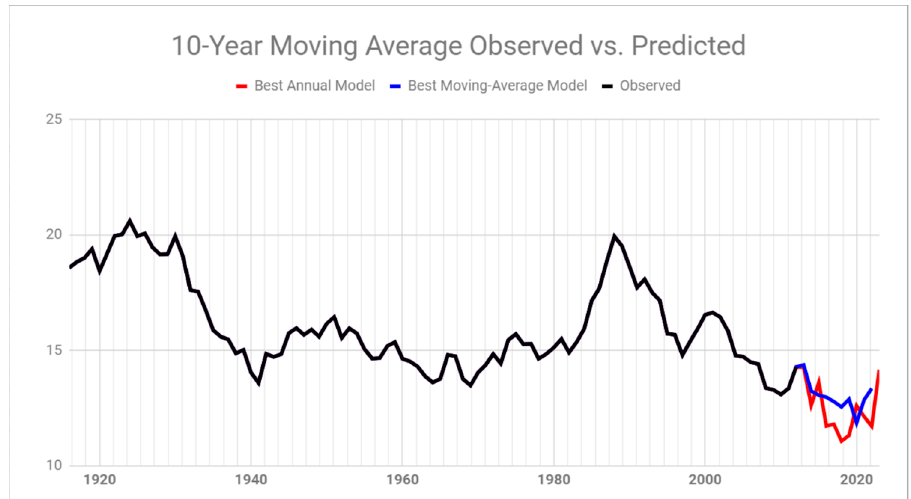
Figure 11. The observed values for the 10-year moving average (black) shown with the predictions (red) 10 years out for the best annual model and the predictions (blue) 10 years out for the best moving-average model.